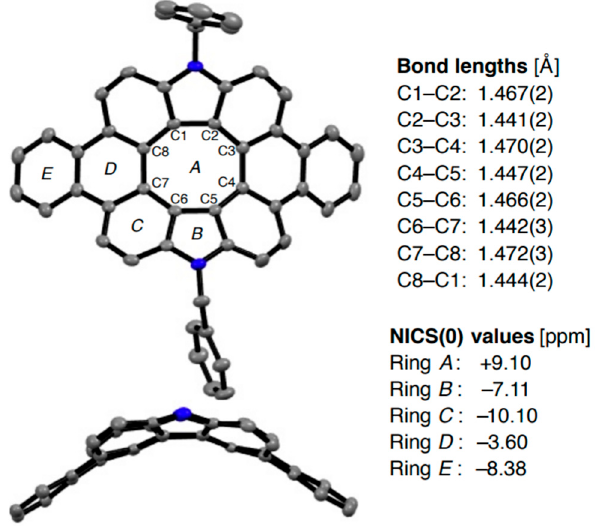
Figure 20. X-ray crystal structure, bond lengths and NICS(0) values of saddle-distorted dibenzodi- aza[8]circulene 54 . Hydrogen atoms, solvent molecules, and peripheral substituents in the side views are omitted for clarity. Reproduced with permission from Maeda et al., Chemistry—A Euro- pean Journal; published by John Wiley & Sons, 2021.